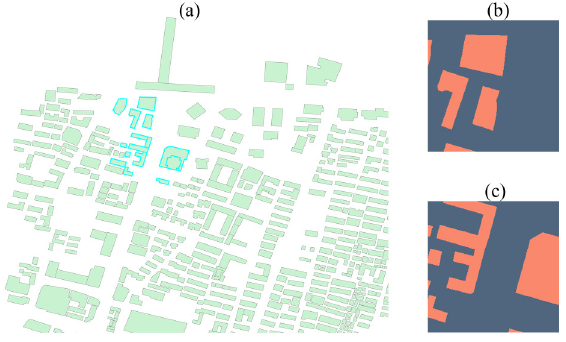
Figure 2 Slice an existing building